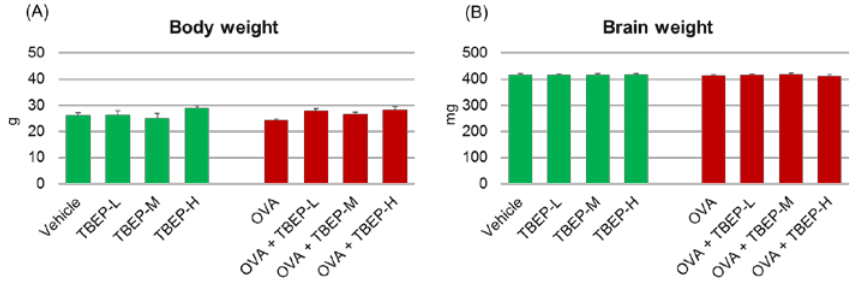
Figure 1. Assessment of general toxicity. ( A ) Body weight and ( B ) brain weight of male mice exposed to TBEP with or without OVA immunization.